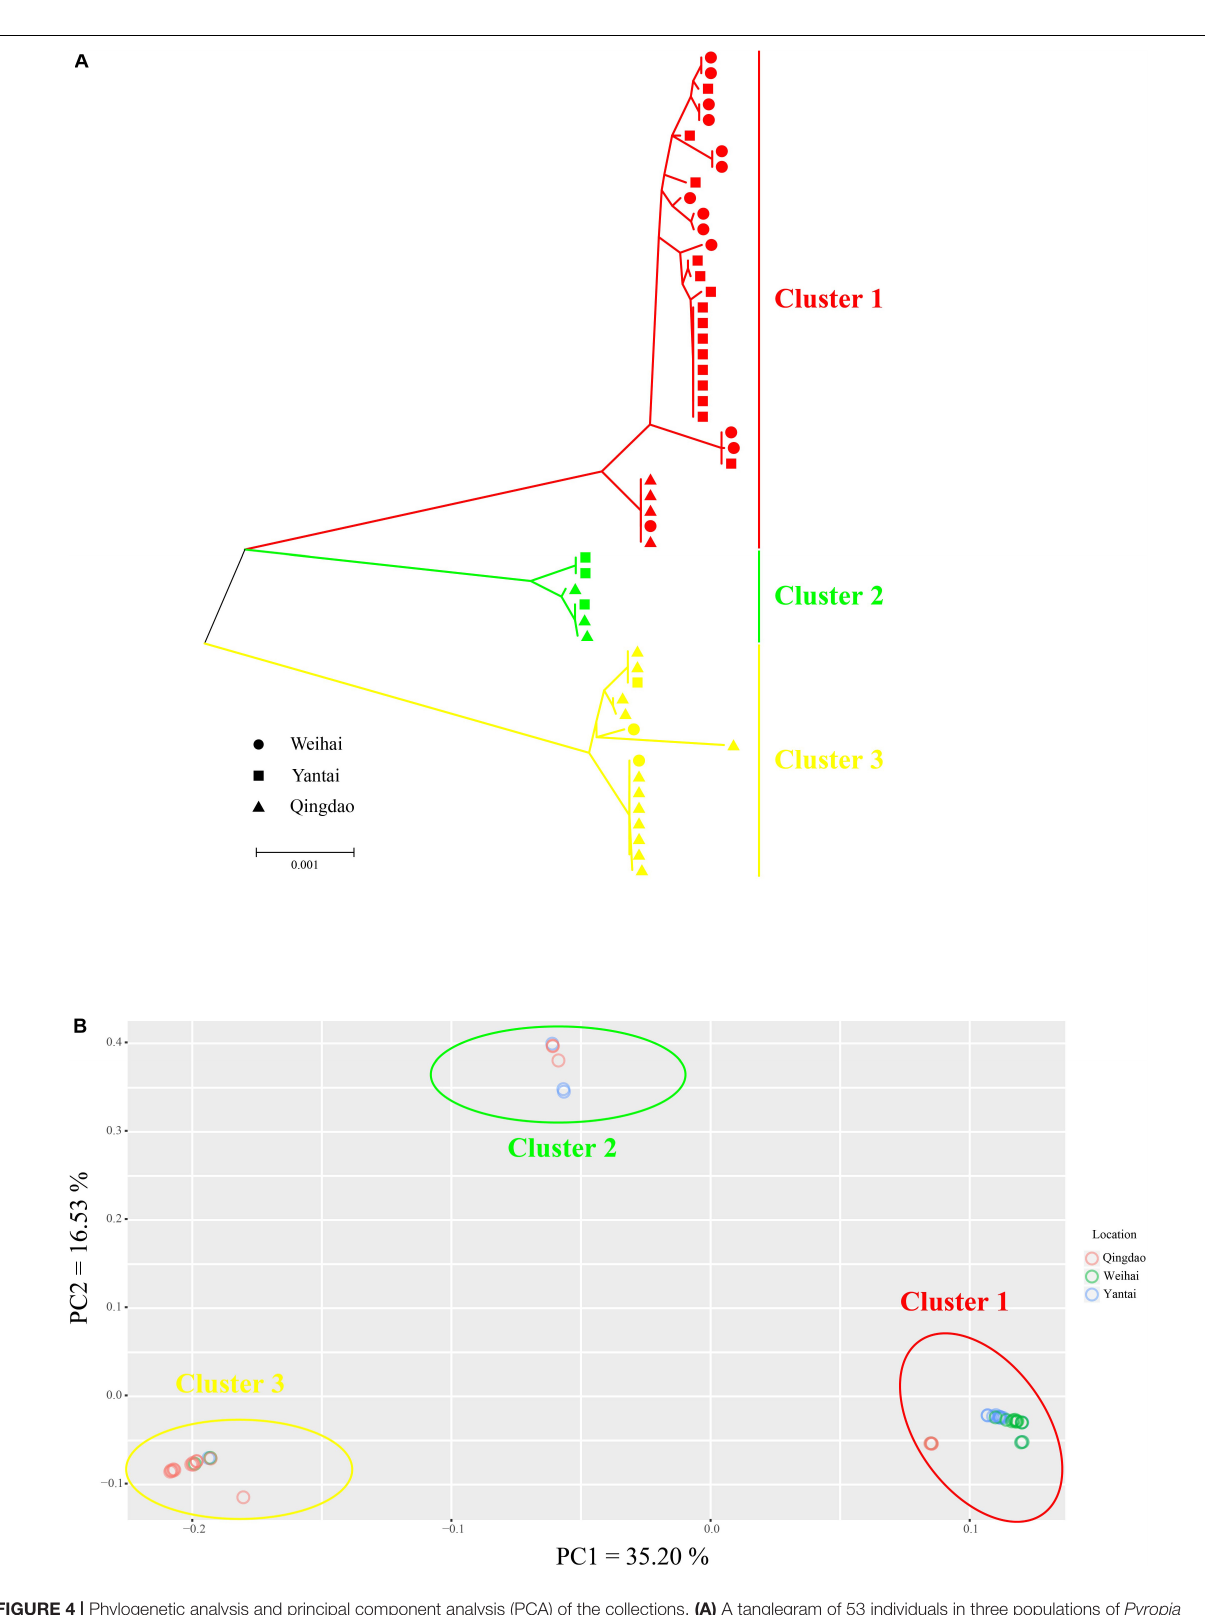
Frontiers in Marine Science |